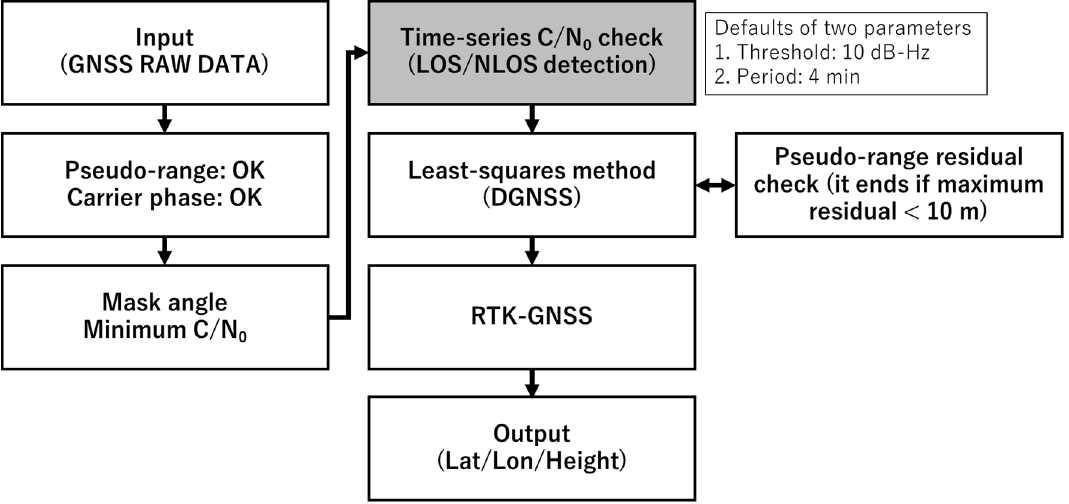
Figure 10. Flowchart of measurement check and positioning based on new concept.